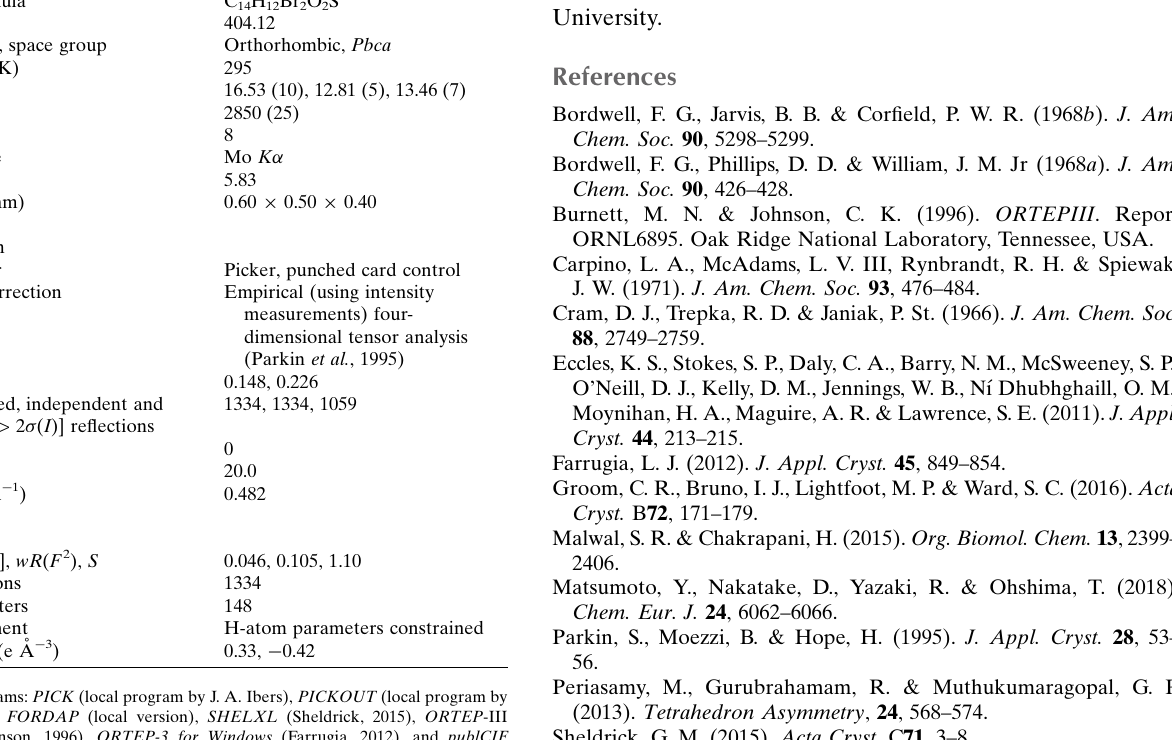
Table 2 Experimental details. Crystal data Chemical